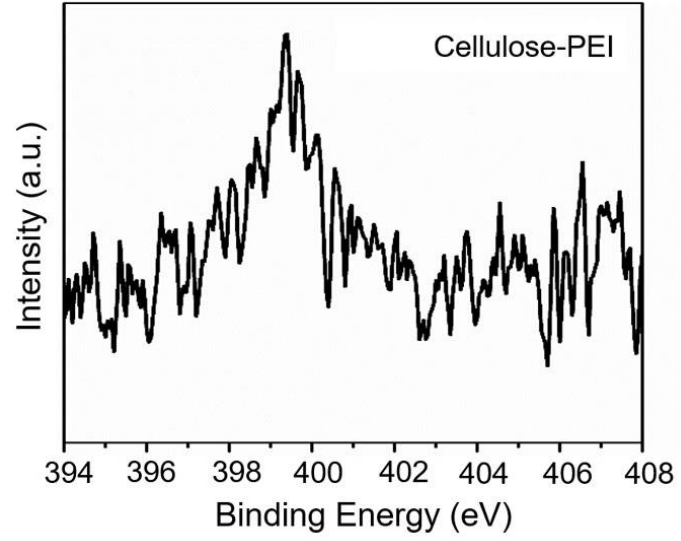
Figure 4. XPS spectrum of cellulose-PEI.